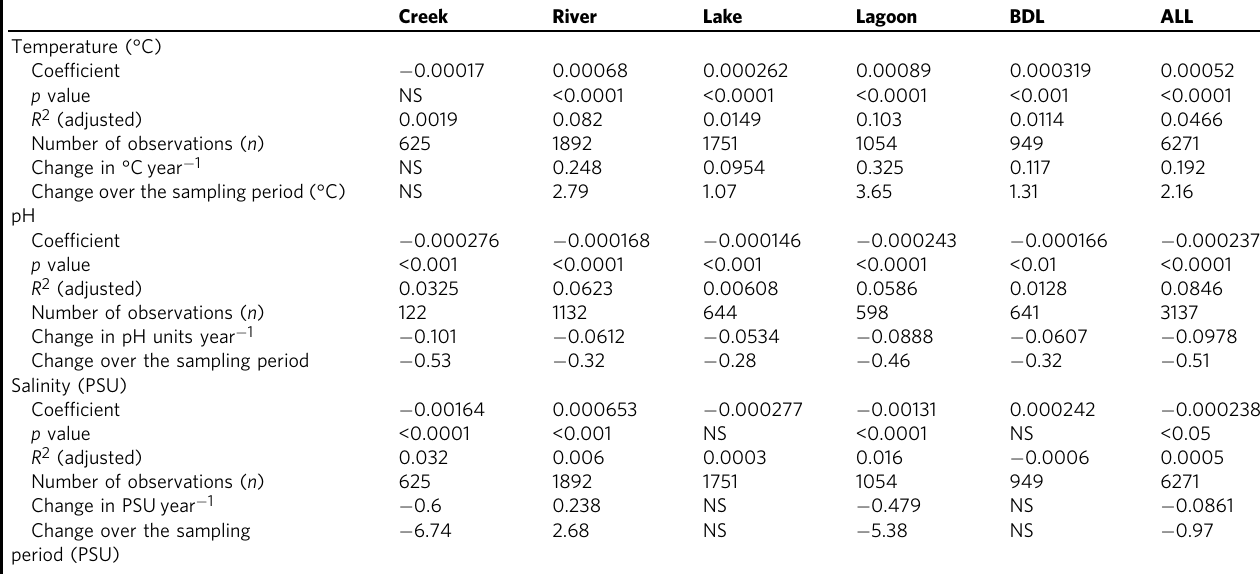
Table 2 Results of simple linear models for temperature, pH and salinity over time categorised by estuary type.